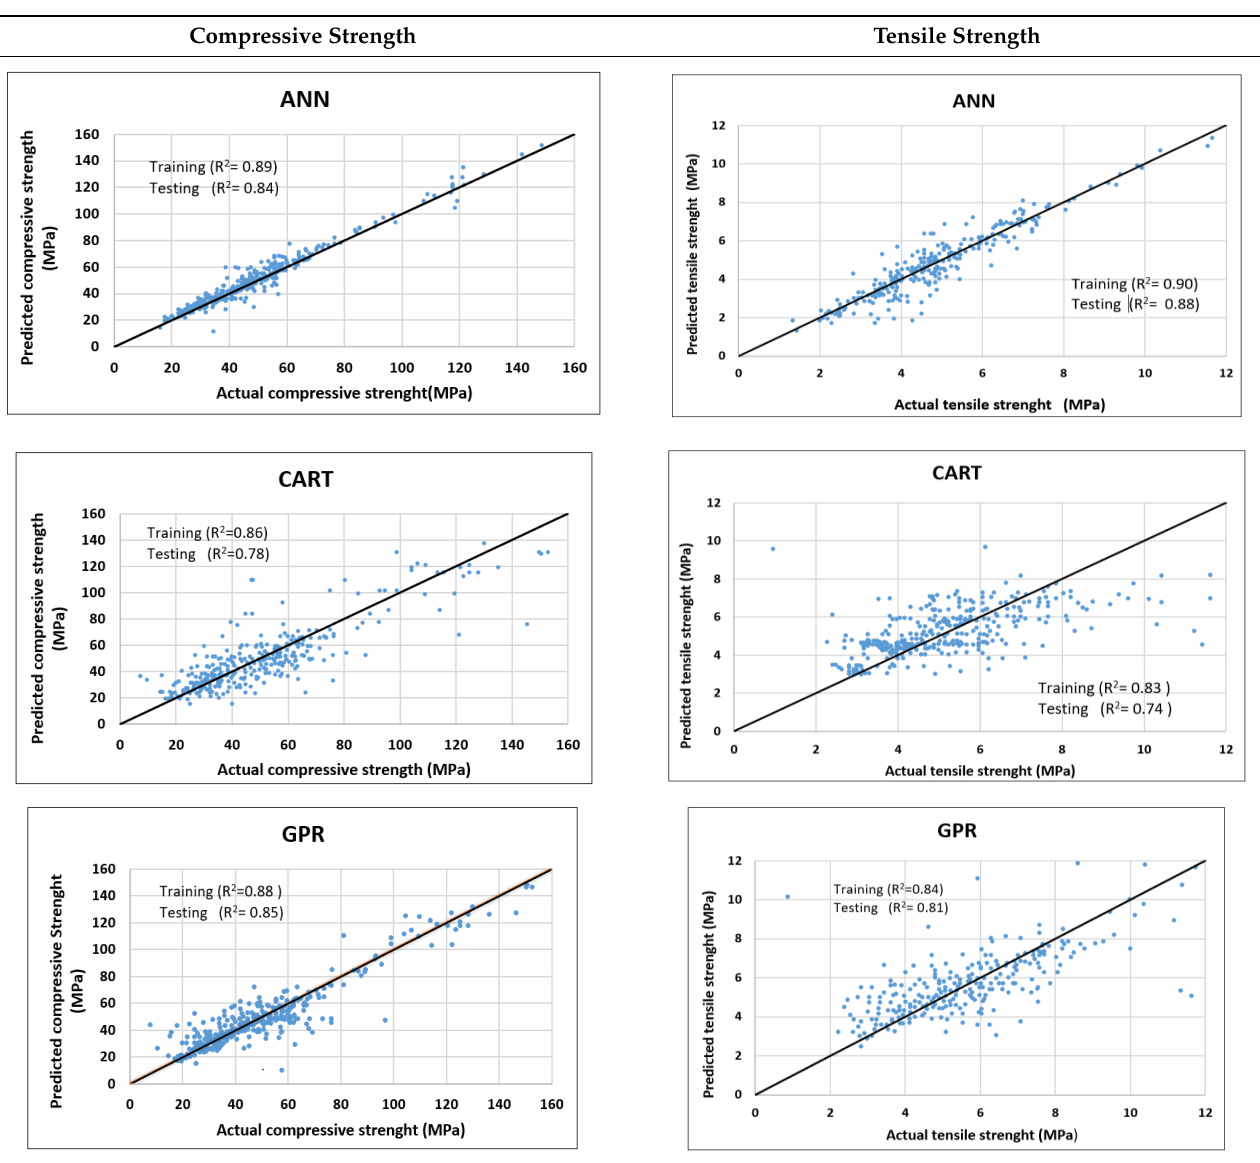
Table 3. Comparison of predicted and actual values of mechanical